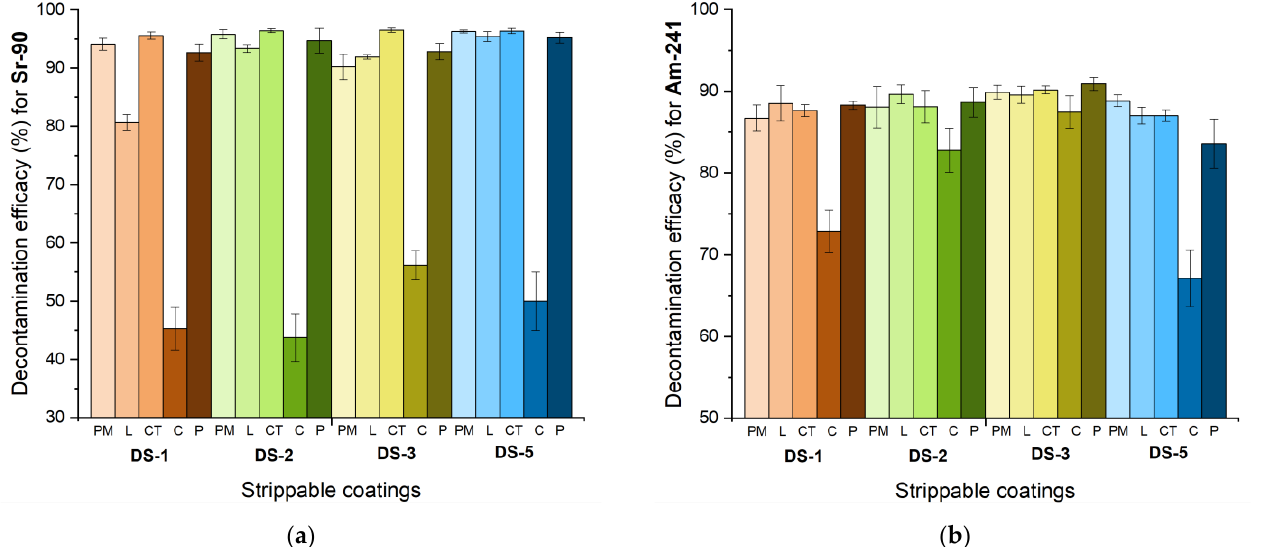
Figure 6. Decontamination efficiency obtained for ( a ) 90 Sr- 90 Y and ( b ) 241 Am.